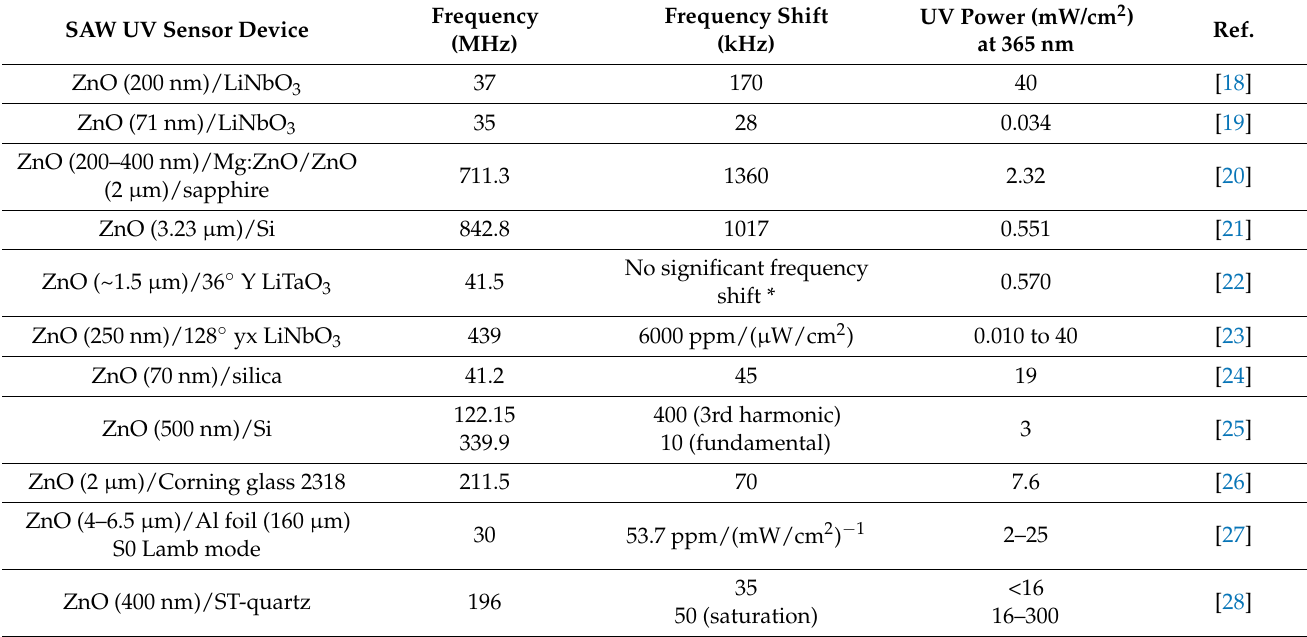
Table 1. The structure of SAW UV sensors, the resonant frequency, the frequency shifts the device undergoes under exposure to UV power, and the corresponding